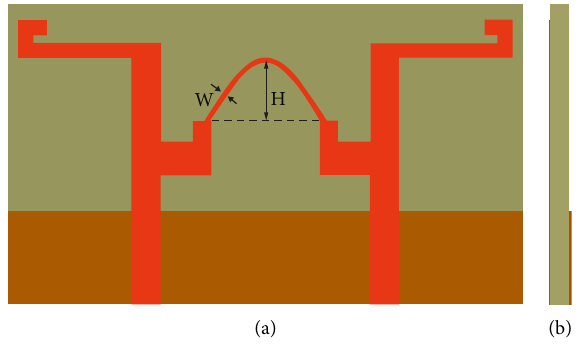
Figure 5: Structure of antenna#1 with NL: (a) perspective view and (b) end view.